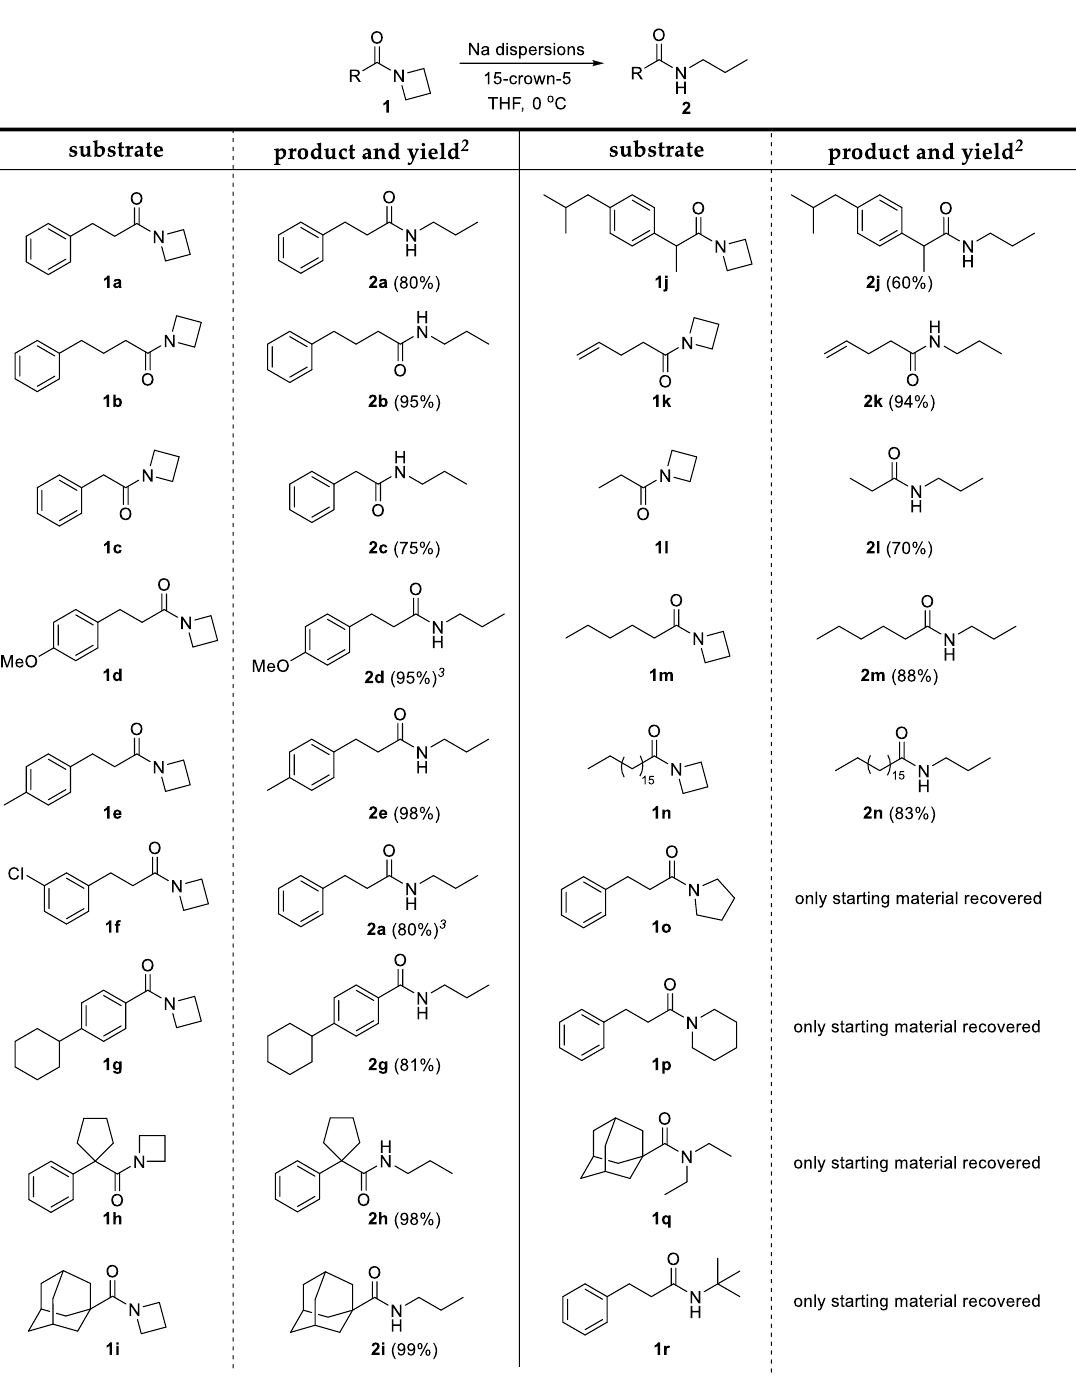
Figure 1. Selective C - N σ bond cleavage in azetidinyl amides by Na/15-crown-5 1 . 1 Conditions: 1 (0.50 mmol, 1.0 equiv.), Na dispersions (5.0 equiv.), 15-crown-5 (5.0 equiv.), THF (3.0 mL), 0 ℃ . 2 Isolated yield. 3 Na dispersions (8.0 equiv.) and 15-crown-5 (8.0 equiv.) were used.